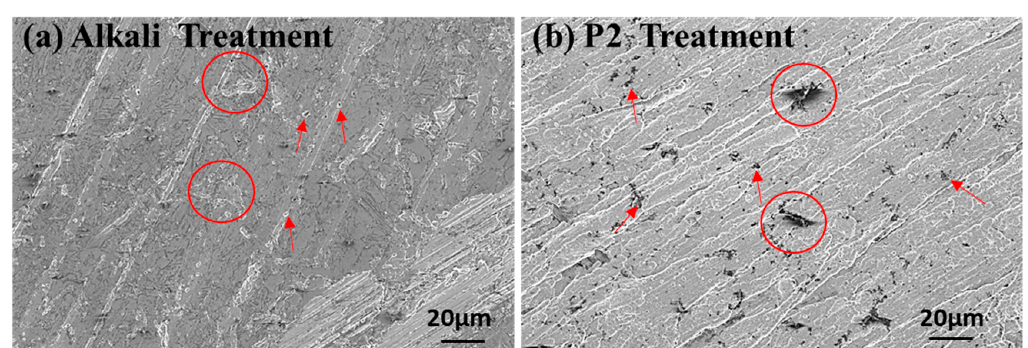
Figure 3. 3D atomic force microscope (AFM) height images of the Al alloy with different surface treatment, ( A1 ) untreated, ( B1 ) mechanical polishing (MP) treated, ( C1 ) Mechanical polishing and the alkali solution immersion (MPAL) treated, ( D1 ) Mechanical polishing, alkali solution immersion, and silane coupling agent surface (MPALSi) treated, ( E1 ) P2 etching (P2) treated and ( F1 ) P2 etching and silane coupling agent surface (P2Si) treated Al alloy. Figure 4. Surface morphology of ( a ) alkali-treated and ( b ) P2 treated Al alloy. Table 3. The roughness data of the different surface modified Al alloy sheets obtained using an atomic force microscope (AFM).